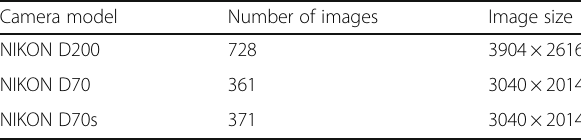
Table 2 Camera models and image information for